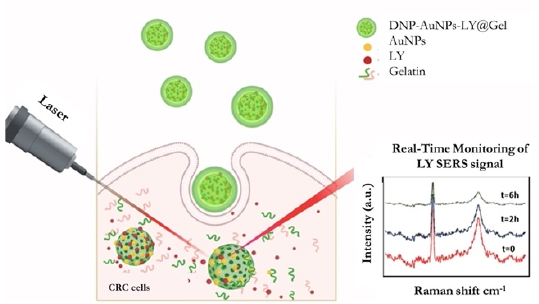
Fig.1. Scheme of the hybrid nanoplatform internalization and real-time monitoring of the released drug. The gelatin shell around the hybrid system acts as a pH-sensitive drug gatekeeper. It is disrupted in the acidic microenvironment of the CRC cells, enabling the controlled release of LY in malignant cells. The monitoring and quantification of the released drug are performed by SERS